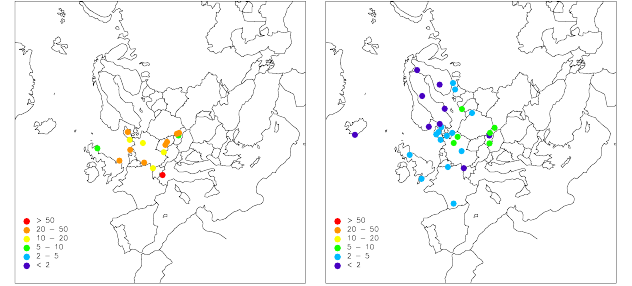
Fig. 19. Average concentrations of Pb in aerosols in 1990 and 2009 (unit ng Pb m − 3 ) .